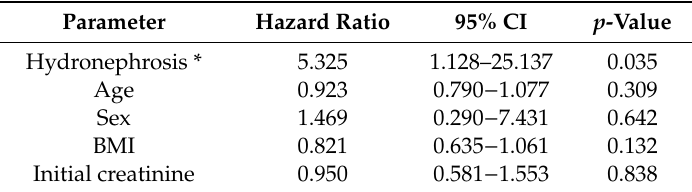
Table 3. Multivariate analysis of risk factors associated with renal outcome among ketamine uropathy patients using a Cox proportional hazards